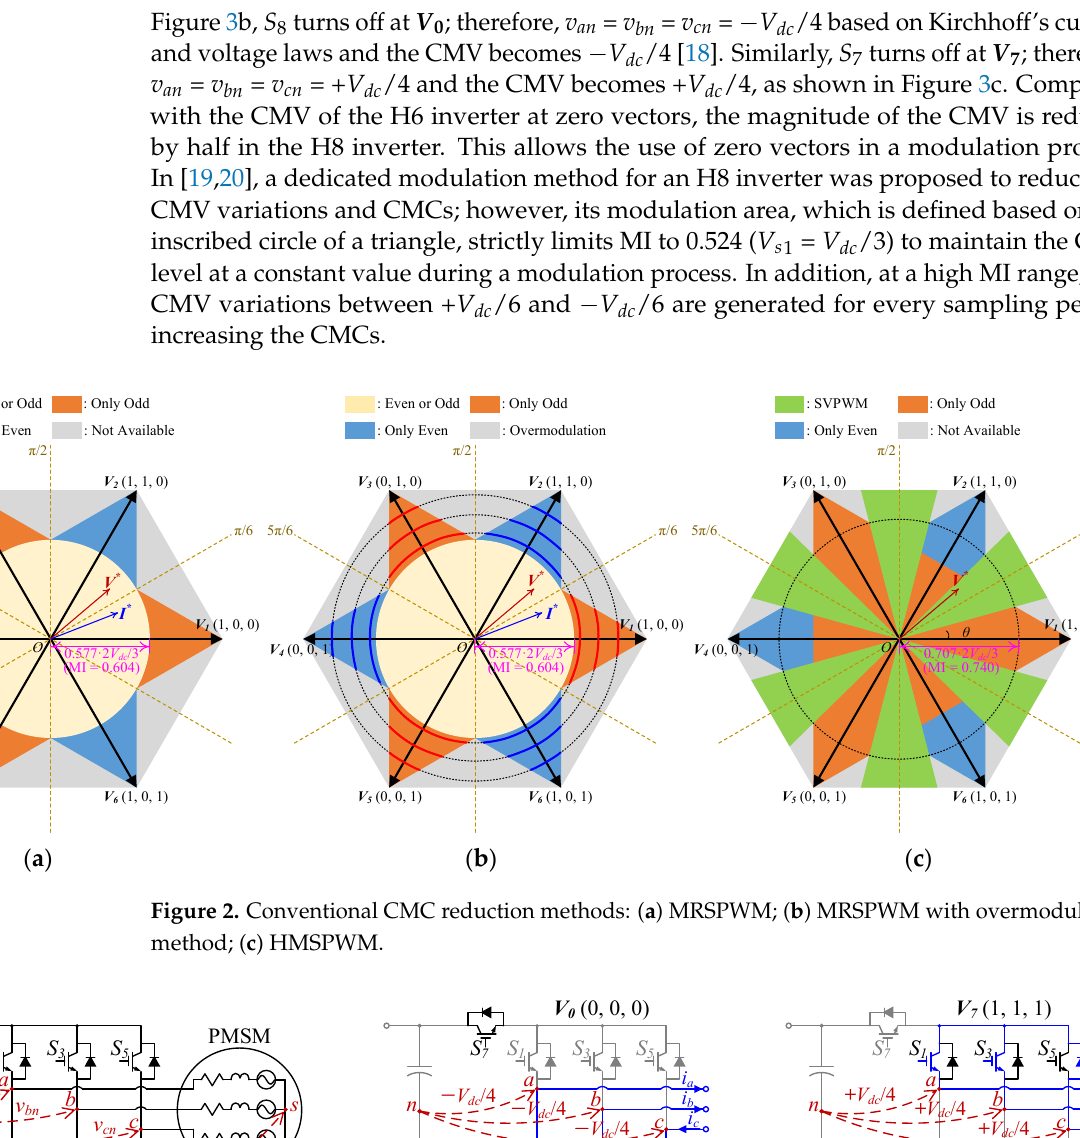
Figure 3. Circuit configuration and operation of H8 inverter: ( a ) Circuit configuration; ( b ) Circuit operation at V 0 ; ( c ) Circuit operation at V 7 .